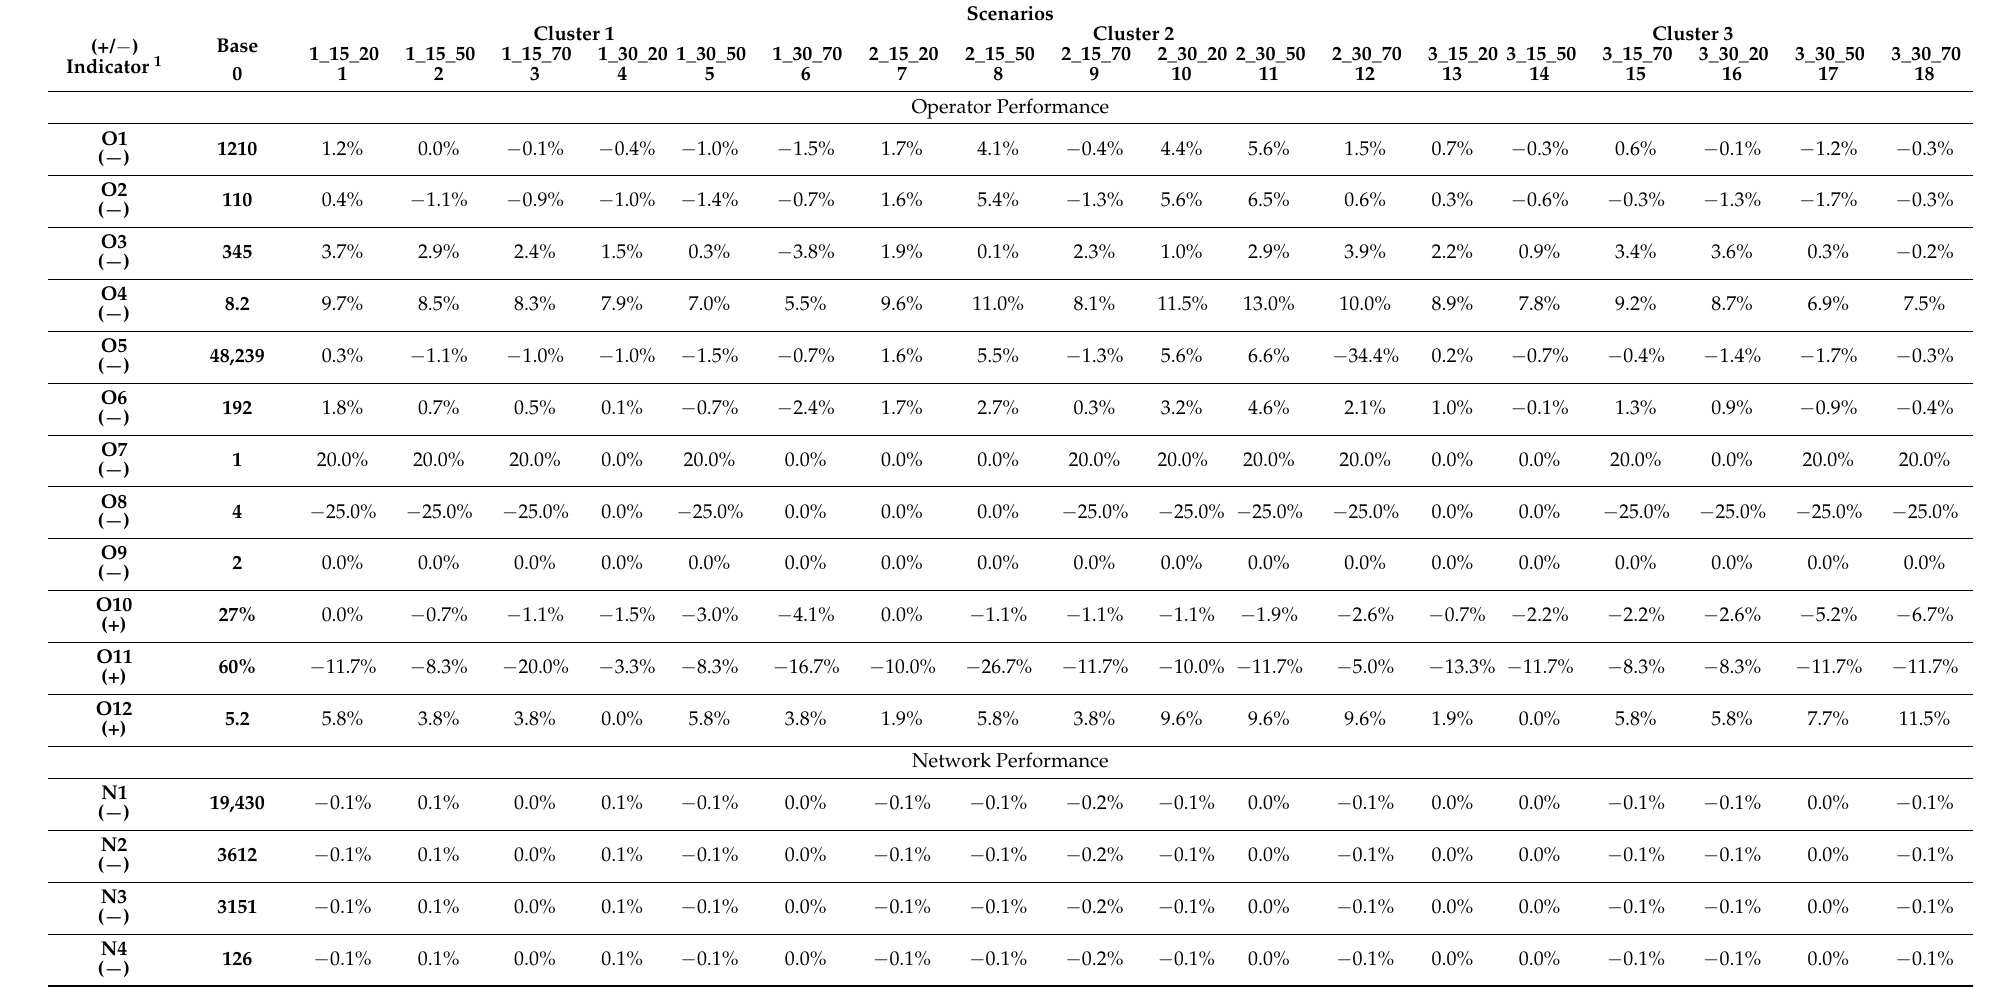
Table 6. Scenario indicator values change as compared to the base scenario indicator